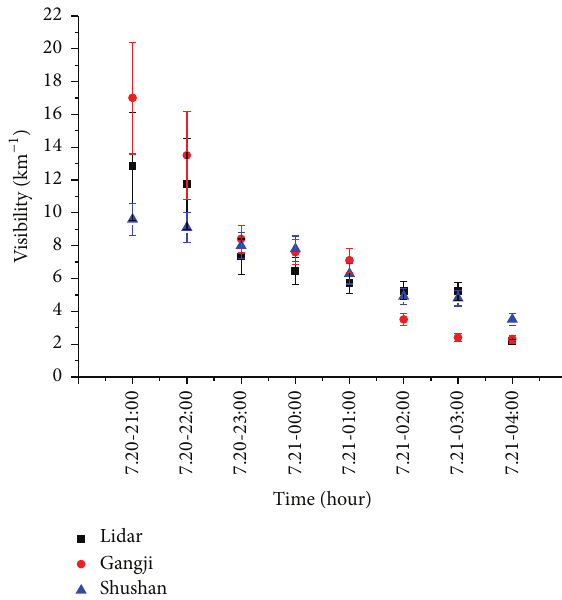
Figure 7: The comparison diagram of the visibility measured by the dual field of view lidar and forward scatter visibility meter.